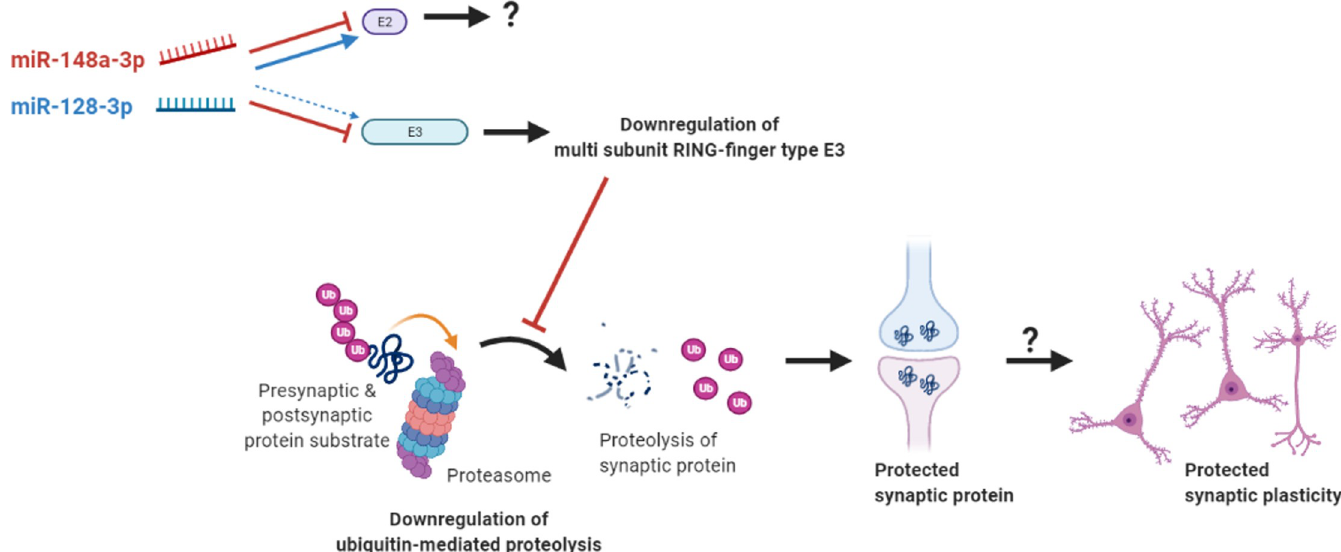
Fig 5. A hypothetical schematic model of the mode of action for acute subanesthetic ketamine treatment mediated by prefrontal miRNAs. Acute subanesthetic ketamine rapidly modified the expression patterns of miR-148a-3p and miR-128-3p in the mPFC, which may lead to the alteration of the genes related to E2 and multi subunit RING-finger type E3. The ketamine-responsive miRNAs are expected to influence ubiquitin-mediated proteolysis of synaptic proteins, which would affect prefrontal synaptic plasticity and exert acute subanesthetic ketamine effects. protein. Multi subunit type RING-finger-type E3 SKP1-culling-F-Box protein (SCF) is